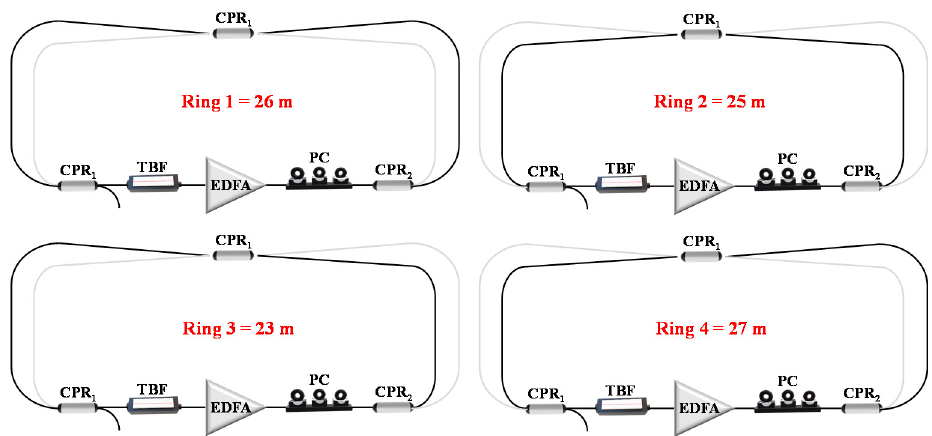
Figure 2. Schematic of Ring 1, Ring 2, Ring 3, and Ring 4 in the EDF quad-ring laser, respectively.